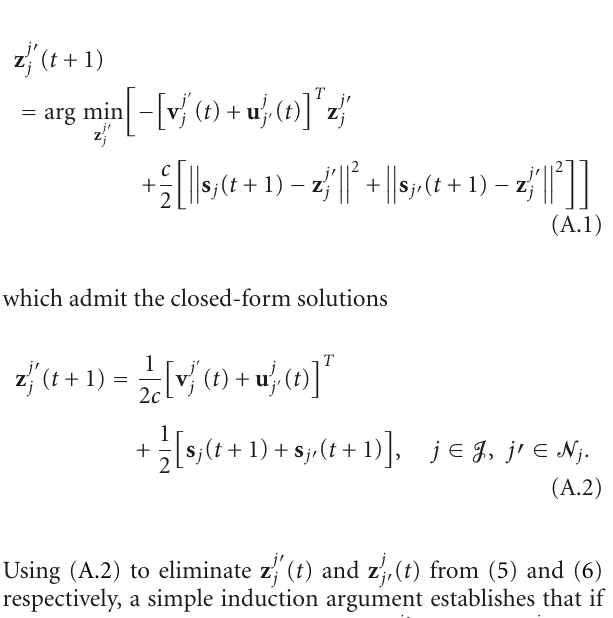
Figure 7: Tracking with D-LMS: slow and optimal adaptation